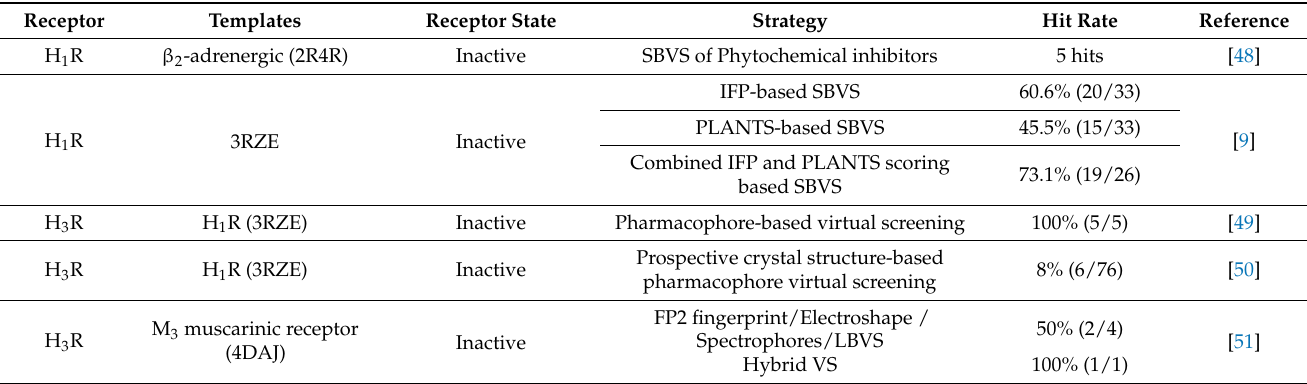
Table 1. Overview of the drug design strategies for discovery of HR ligands. In parenthesis the PDB ids of templates used in homology